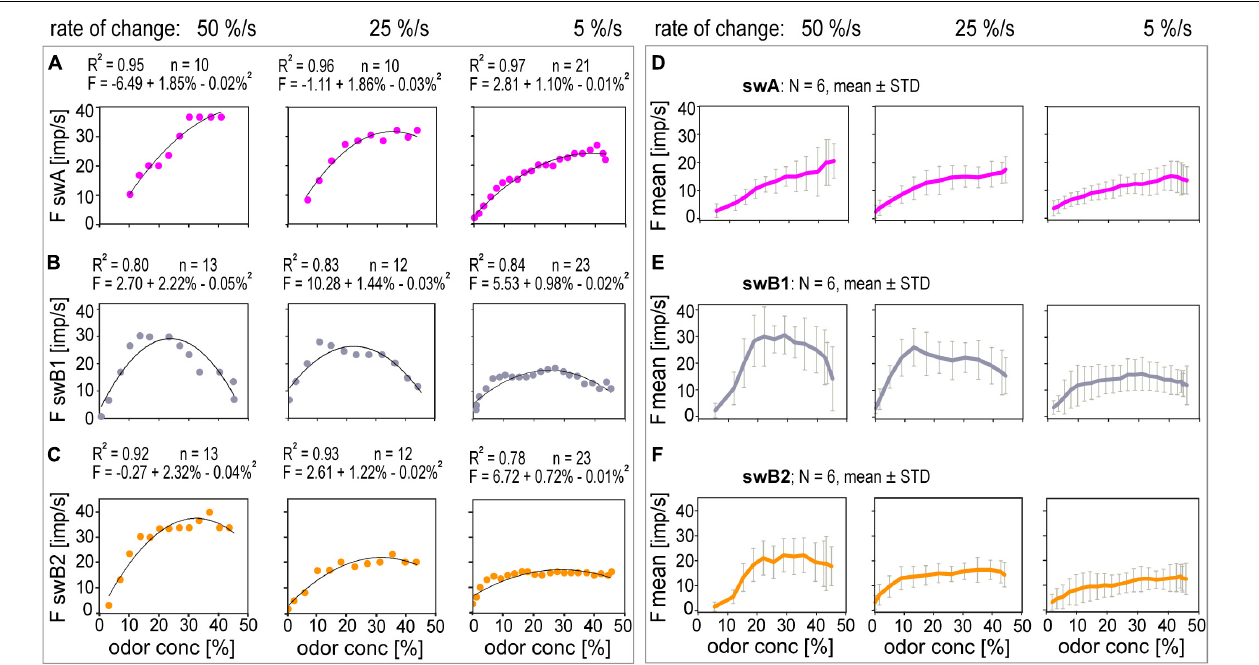
FIGURE 8 | Stimulus-response functions of ORNs located in the swA , swB1 and swB2 sensilla ORNs to ramp-like concentration changes at rates indicated. Single ORNs of (A) swA sensillum, (B) swB1 and (C) swB2 sensillum, pooled responses of (D) 6 swA ORNs, (E) 6 swB1 and (F) 6 swB2 ORNs. Parabolic regressions were used to approximate the stimulus-response relationships. Bin widths for impulse counts were 0.1 s for 50%/s ramps, 0.2 s for 25%/s ramps and 0.5 s for 5%/s